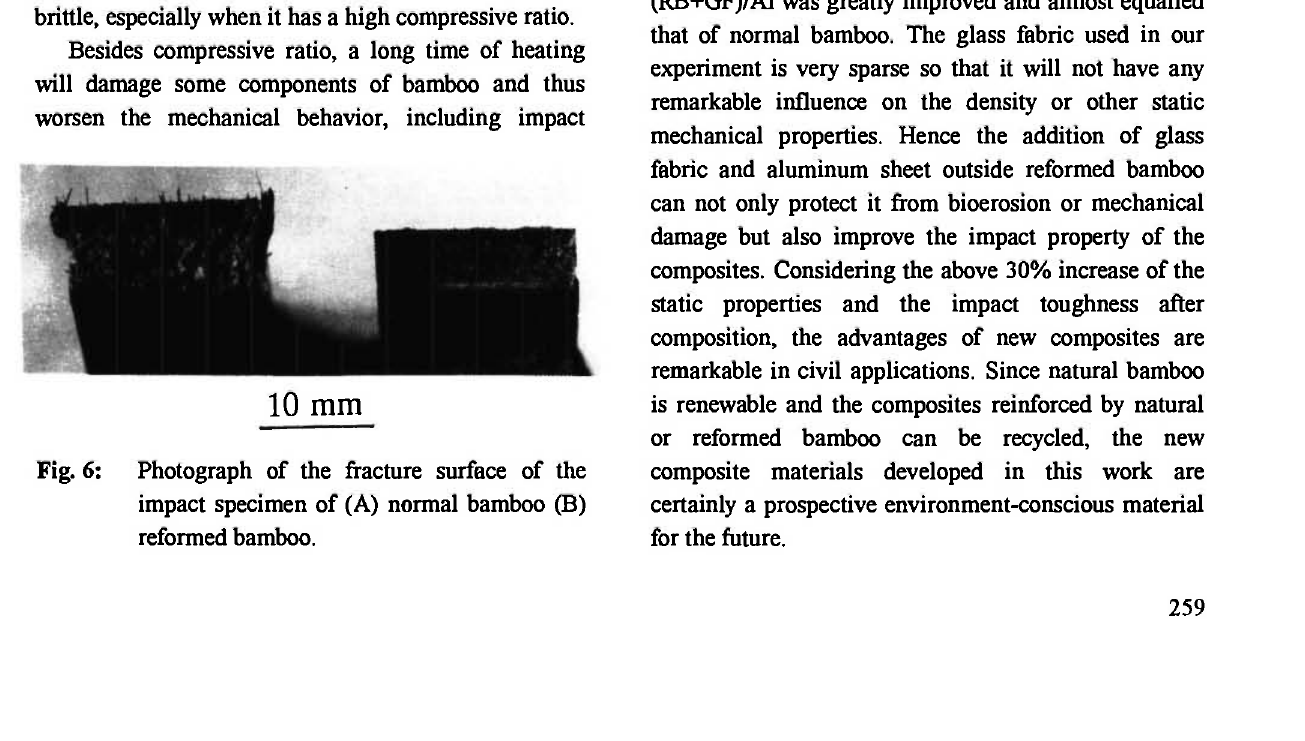
Fig. 6: Photograph of the fracture surface of the impact specimen of (A) normal bamboo (B) reformed